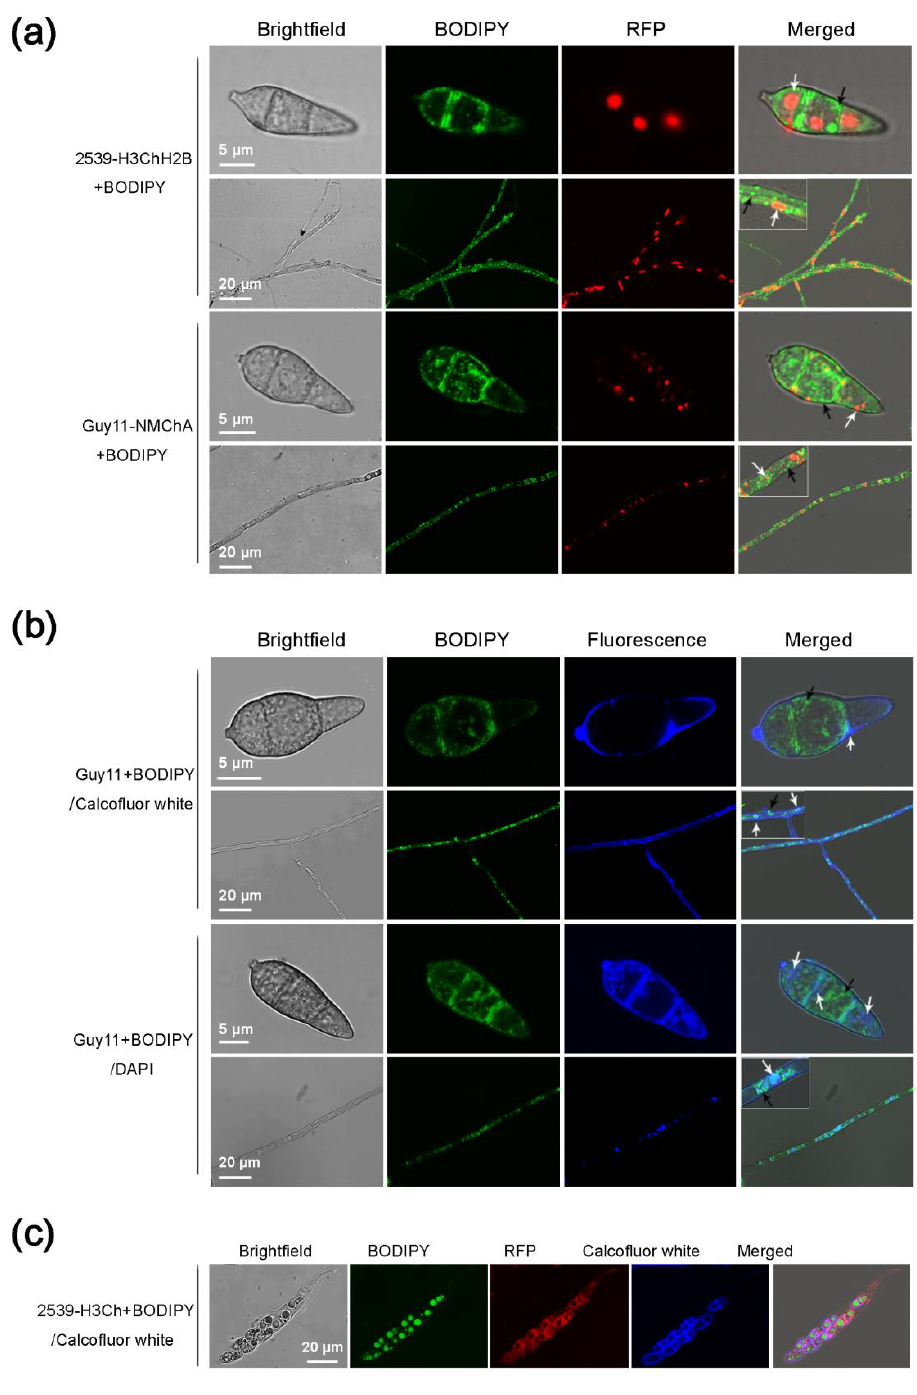
Figure 4. Multiple staining of the conidia, mycelia and ascospores of Magnaporthe oryzae with BODIPY in combination with the red fluorescent protein mCherry, Calcofluor white, and DAPI. ( a ) Staining of the conidia and mycelia of strain 2539-H3ChH2B (strain 2539 with mCherry-labeled nuclei) and strain Guy11-NMChA (strain Guy11 with mCherry-labeled peroxisomes) with BODIPY; ( b ) Double staining of the conidia and mycelia of strain Guy11 with BODIPY/Calcofluor white or BODIPY/DAPI; ( c ) Staining of the asci formed by strains Guy11 and 2539-H3Ch (strain 2539 expressing mCherry) with BODIPY/Calcofluor white. Black arrows indicate the BODIPY-stained lipid droplets; white arrows indicate respectively the red fluorescent protein-labeled nuclei or peroxisomes in ( a ), and Calcofluor white-stained cell walls or DAPI-stained nuclei in ( b